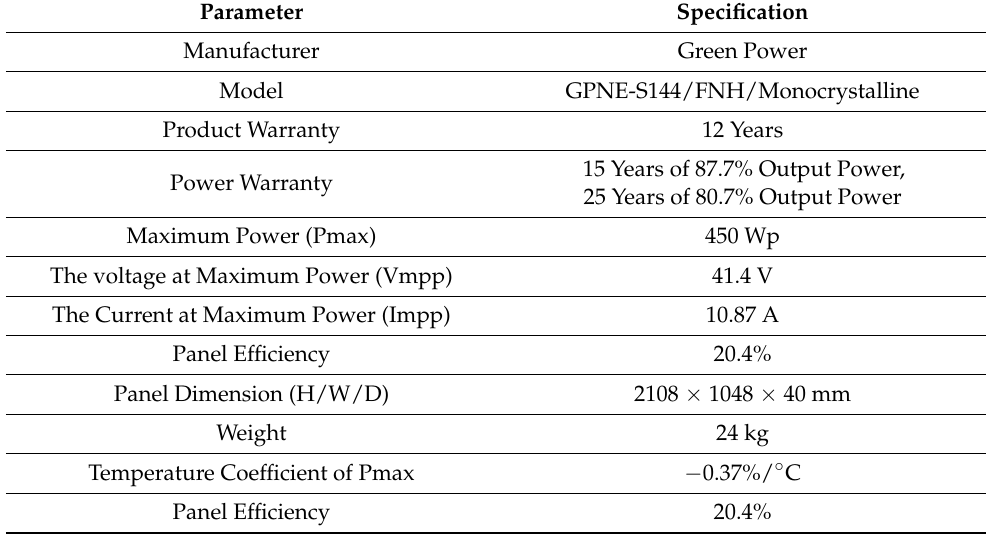
Table 1. Technical parameters of PV arrays.